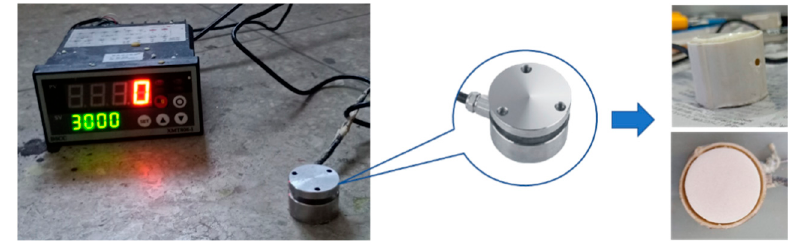
Figure 2. Pressure sensor with heat preservation.